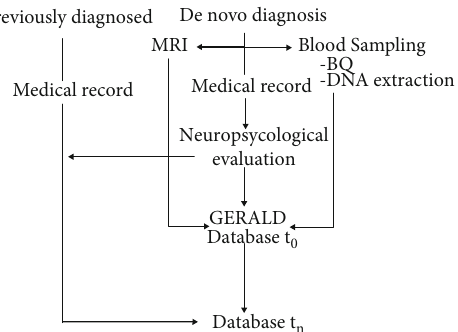
Figure 1: Diagram showing GERALD project pipeline. De novo diagnoses undergo a full neuropsychological evaluation together with CNS magnetic resonance imaging (MRI). Peripheral blood extraction is used for both biochemical (BQ) analysis and DNA extraction for ApoE genotyping. Relevant data from the medical records, together with the di ff erent tests results, are integrated in a database. Subsequent follow-up results are also digitalized. Previously diagnosed patients undergo the neuropsychological evaluation which is longitudinally